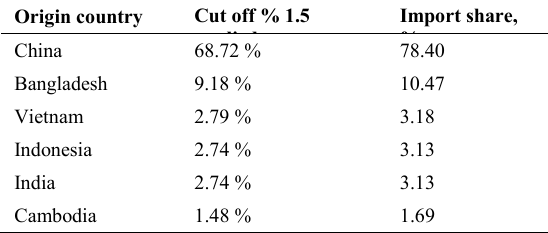
Table A2 represents apparel import share percentage by country of origin. A cut of approach of 1.5 % was applied to estimate the apparel import share of six biggest apparel origin